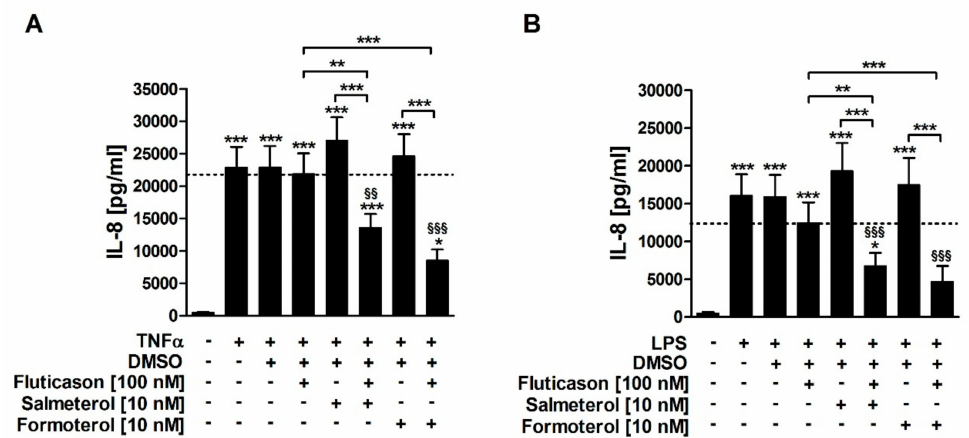
Figure 1. Both formoterol and salmeterol reverse the corticosteroid insensitivity of IL-8 in human airway smooth muscle cells (HASMCs) of subjects with chronic obstructive pulmonary disease (COPD). HASMCs ( n = 5) of COPD subjects were treated with fluticason propionate (100 nM), formoterol (10 nM), salmeterol (10 nM) or with DMSO (0.45%; solvent control) two hours prior to stimulation with TNF α (20 ng / mL, ( A )) or LPS (1 µ g / mL, ( B )). After 72 h of incubation, IL-8 was measured in culture supernatants by ELISA. Data are presented as mean ± SEM. One-way repeated-measures ANOVA with 95% CI: ( A , B ) p < 0.0001; post-hoc Bonferroni analyses: * p < 0.05; ** p < 0.01; *** p < 0.001 vs. unstimulated control or as indicated; §§ p < 0.01; §§§ p < 0.001 vs. TNF α + DMSO (A) or LPS + DMSO